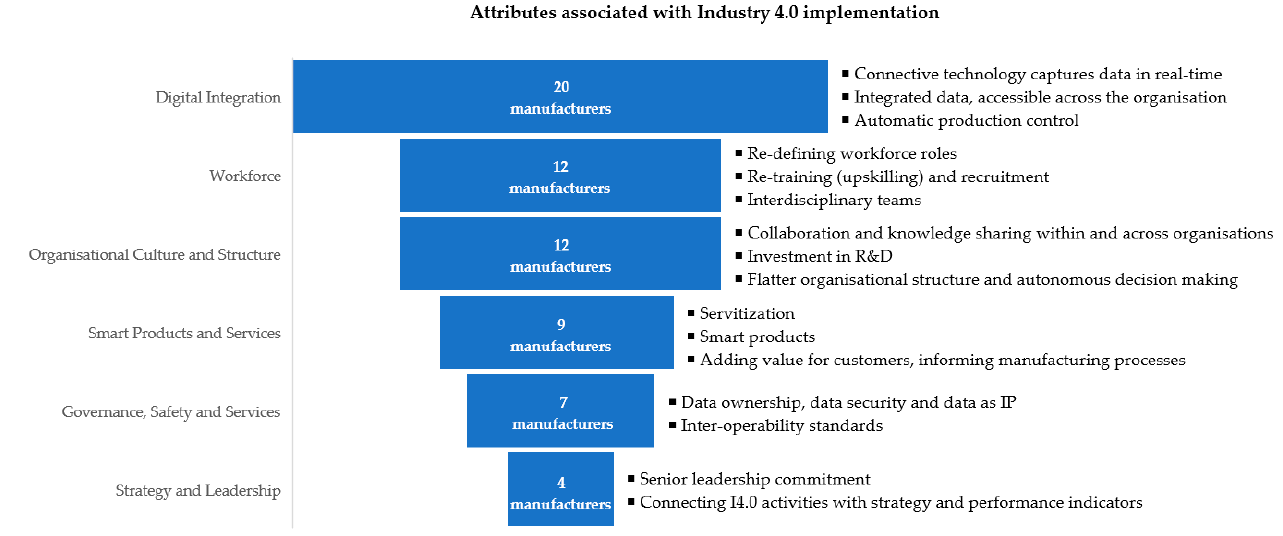
Figure 1. Manufacturers’ descriptions of Industry 4.0 attributes .